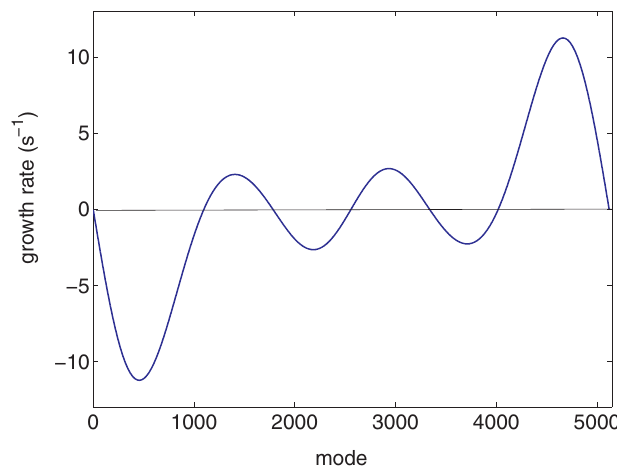
FIG. 23. (Color) Growth rate ( (cid:6) (cid:5) 1 ) of longitudinal coupled- bunch mode ( M (cid:1) 5120 ).